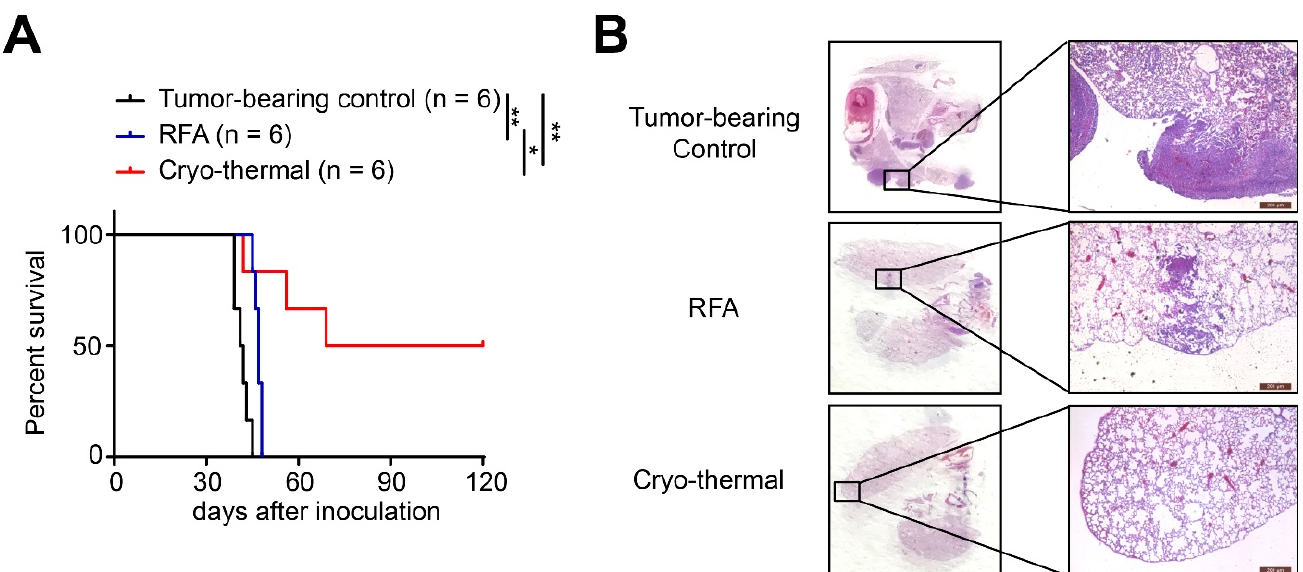
Figure 1. Cryo-thermal therapy induced long-term antitumor protection in 4T1-bearing mice. ( A ) Kaplan–Meier survival curve of tumor-bearing control, traditional RFA or cryo-thermal therapy treated mice. Approximately 4 × 10 5 4T1 cells were injected subcutaneously into the right flank of female Balb/c mouse. Then, 18 days later, mice were randomly allocated into three groups, and treated by RFA or cryo-thermal therapy, and untreated mice were as control. Kaplan–Meier survival curve was compared using log-rank tests. * p < 0.05, ** p < 0.01. n = 6 for each group. ( B ) H&E staining of the lung of tumor-bearing control (39 days after inoculation), RFA or cryo-thermal treated group (21 days after treatment).